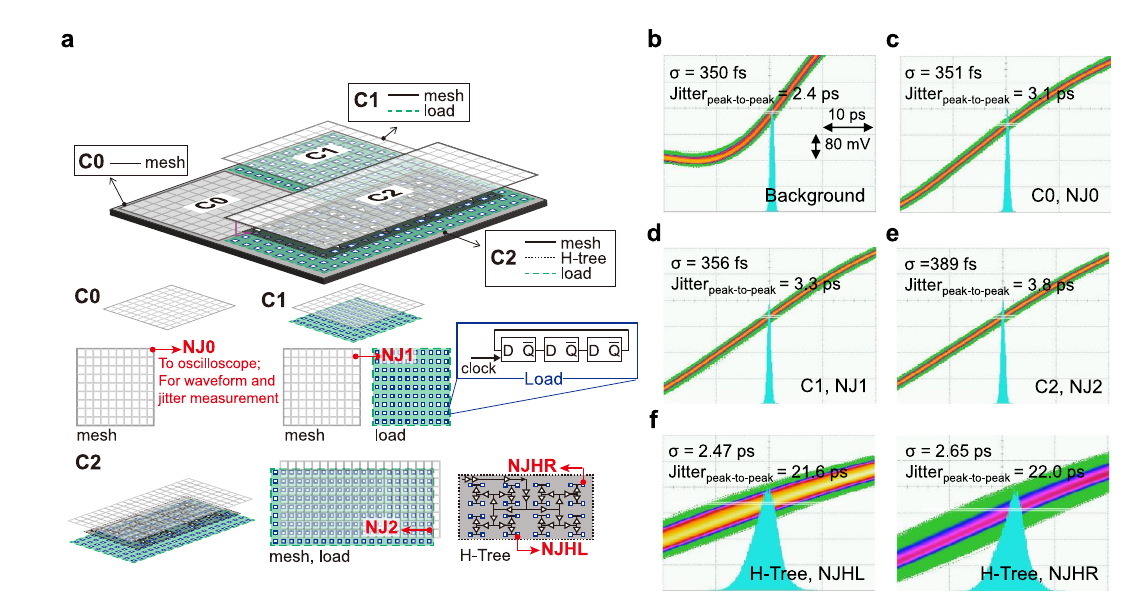
Fig. 3 | Clock jitter measurement results. a Diagram of the test chip related to jitter measurement. Note thatthe output clock signal from C2 is used as the input clock signal of the H-tree. b Jitter measurement background. c – f Jitter histograms ofthegenerated1GHzclocksweremeasuredoff-chipthroughanopen-drainclock